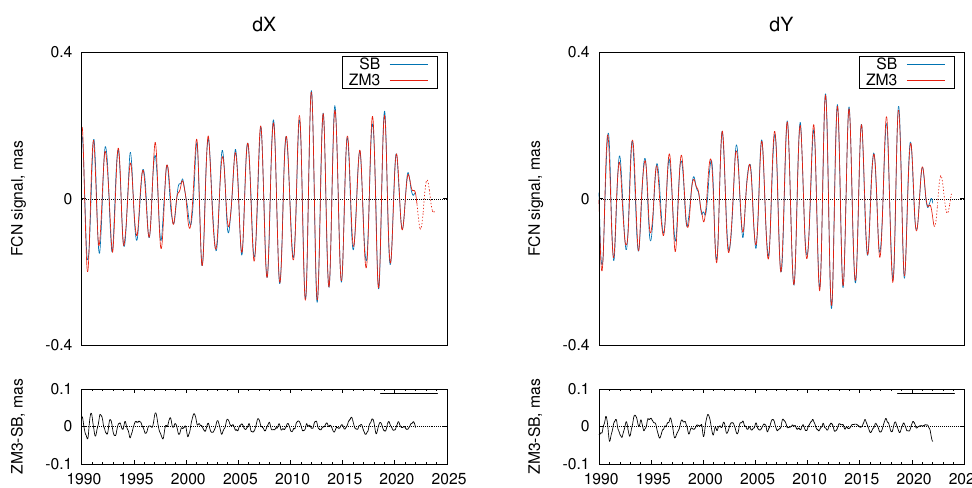
Figure 3. Upper panels: SB (blue line) and ZM3 (red line) FCN series; dashed red line shows ZM3 model prediction. Bottom panels: ZM3 minus SB model differences.